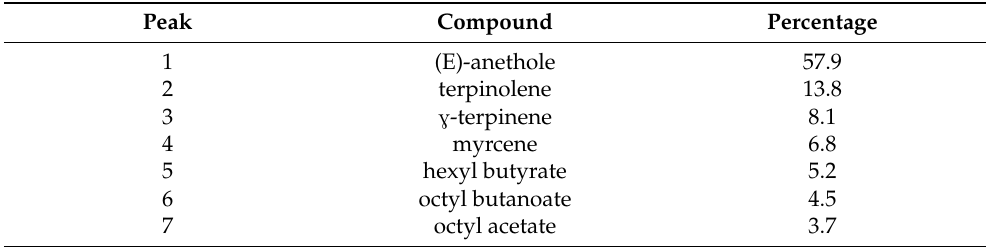
Table 2. Major compounds present in the nanoemulsion synthesized using essential oil obtained from aerial parts of H. persicum.